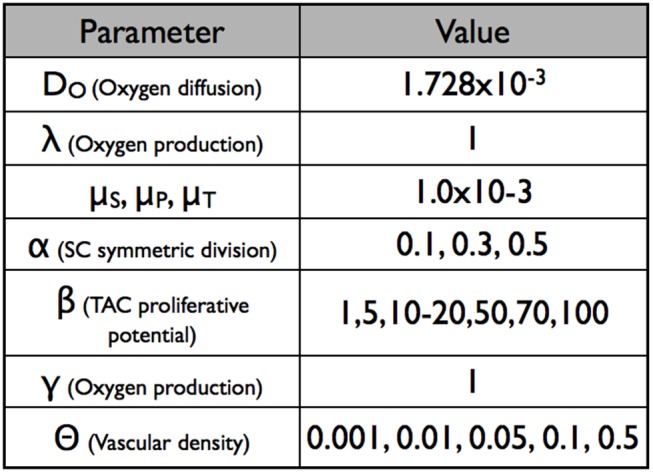
Model parameters.